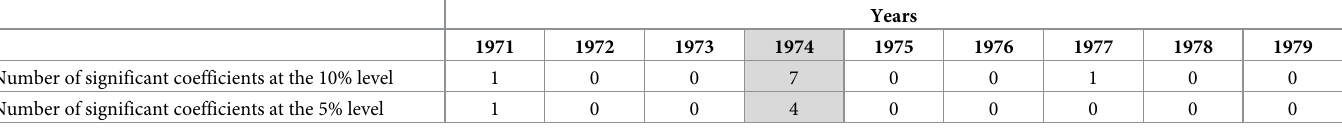
main model (Table 1). Control variables: See Table